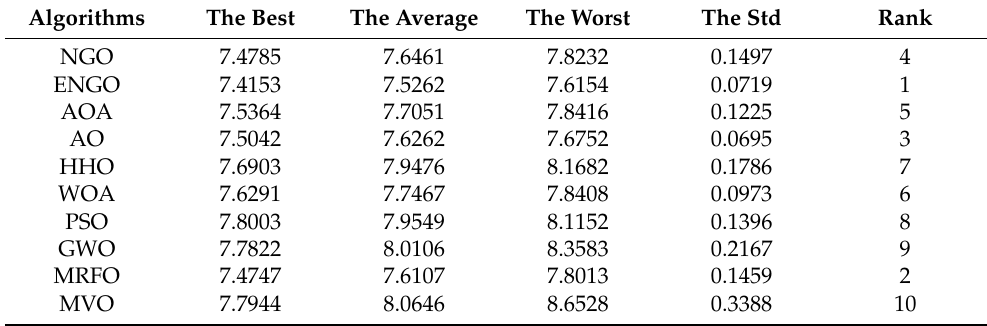
Table 14. The results of the different algorithms for the TSP with 80 cities and three travelling salesmen.